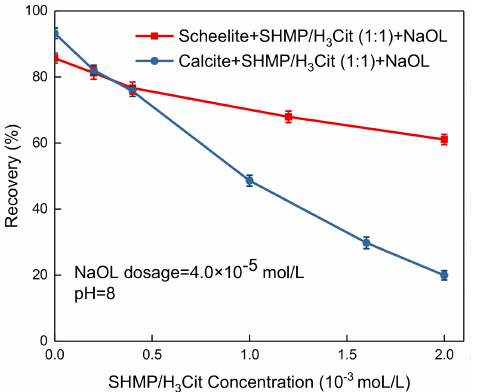
Figure 6. Floatability of minerals as a function of mixed depressant